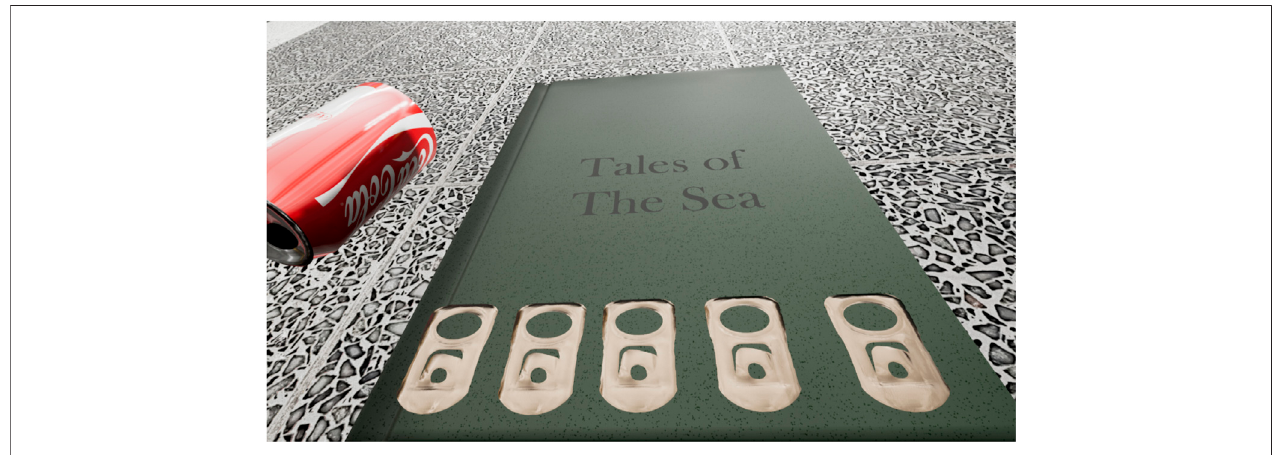
FIGURE 1 | First person perspective from the subject ’ s point of view in the VE at the start of the experiment in Study 1 (Pouke et al., 2020).